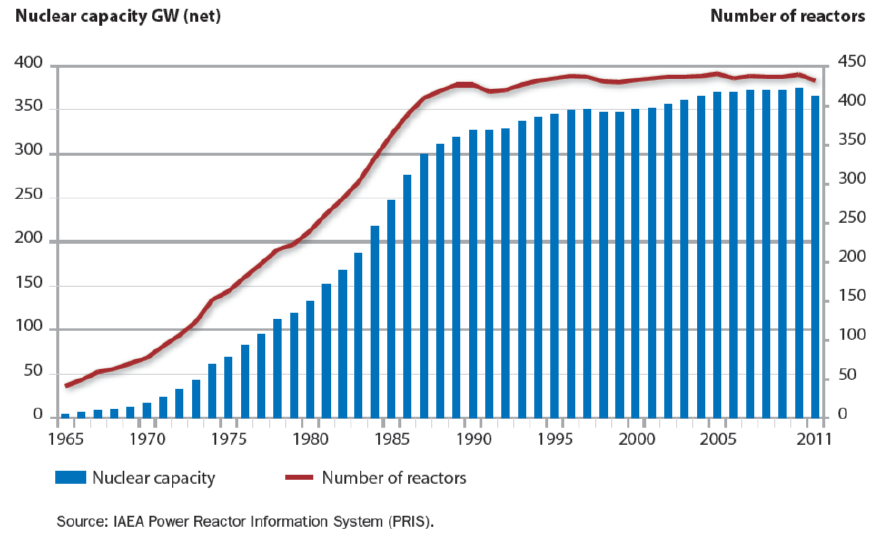
Fig. 6. – Worldwide nuclear generating capacity and number of operating reactors (1965–2011) [5] ( c (cid:2) OECD